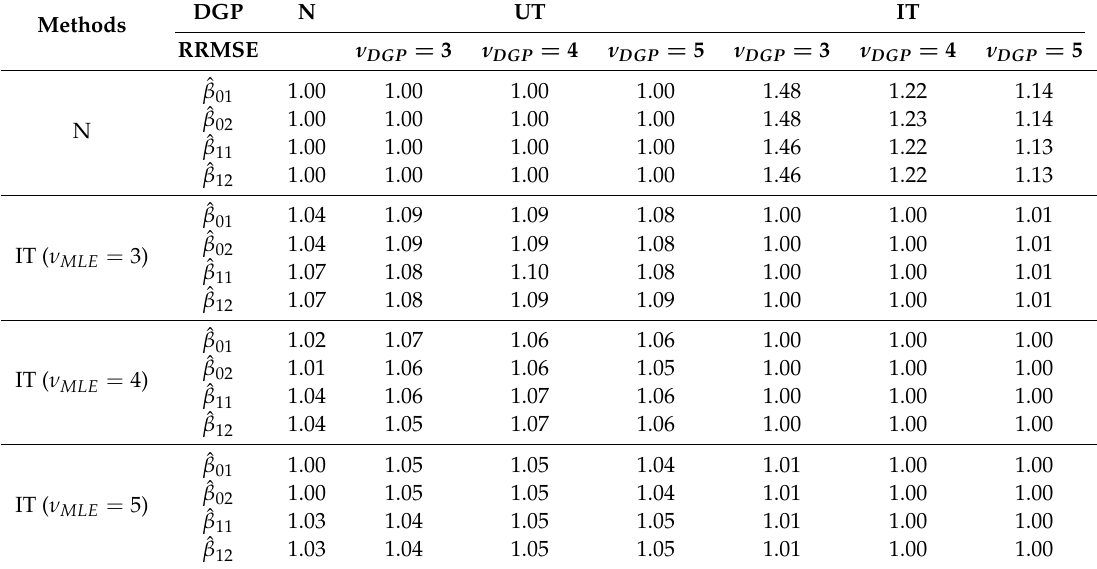
Table 4. The root relative mean squared errors of ˆ β ˆ β ˆ β .